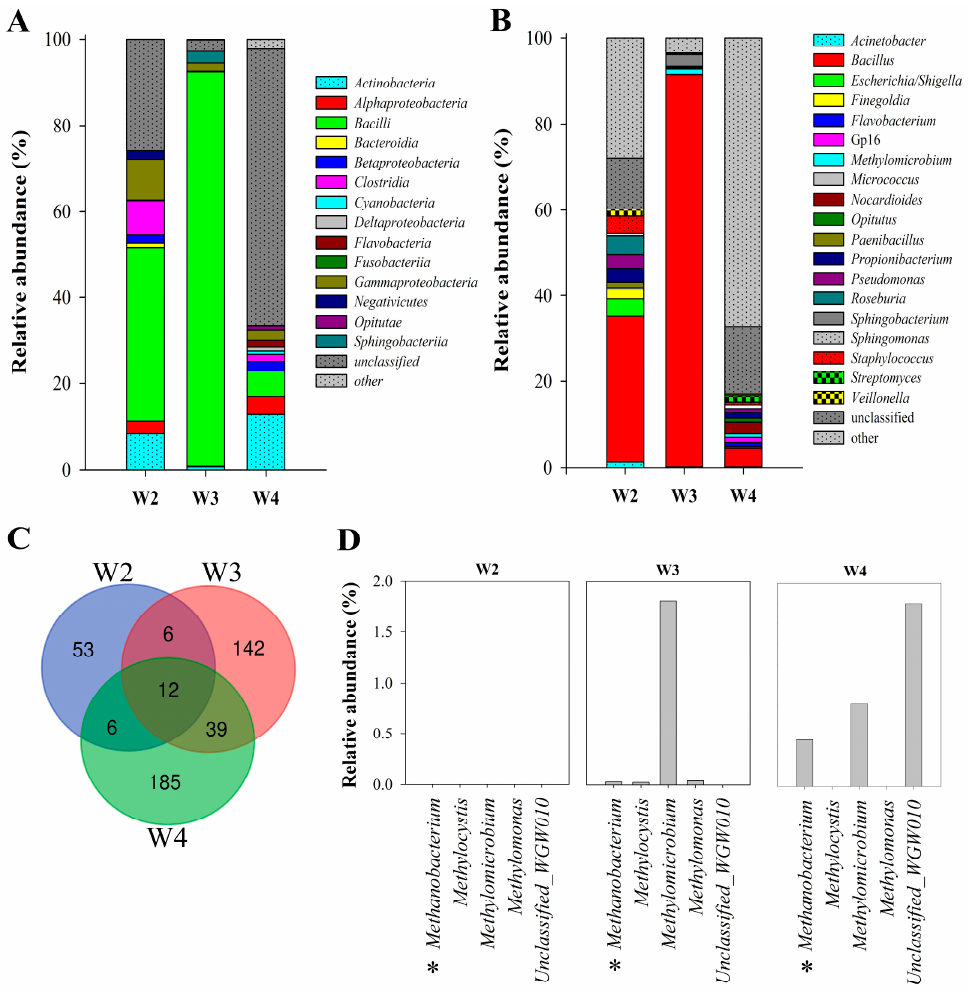
Figure 3. Microbial community structure of Miocene sulphate rocks by 16S rRNA gene amplicon analysis based on Next Generation Sequencing at the class and genus level. Relative abundance (%) of the top 10 classes ( A ) and genera ( B ) of microbes. Venn diagram of overlapping all bacterial communities at the genus level ( C ). Participation of methanotrophic and methanogenic microorganisms (*) in the microbial community ( D ).